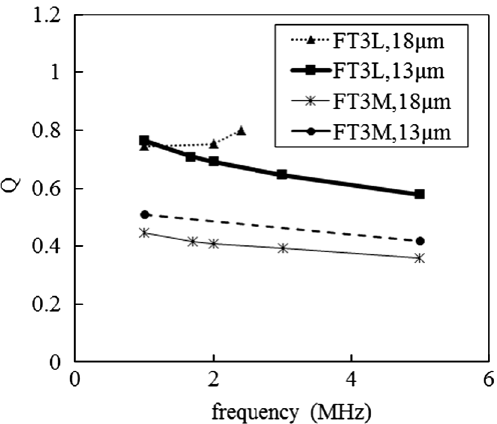
FIG. 3. Q value of MA cores. The present FT3M core (solid line) with 18 (cid:1) m layer thickness can be improved by the FT3L with 13 (cid:1) m thickness (bold line). The dashed line means the Q value of the FT3M with 13 (cid:1) m thickness and shows higher value than 18 (cid:1) m one. The dotted line is that of the FT3L with 18 (cid:1) m thickness and shows about the same Q value as the 13 (cid:1) m one.